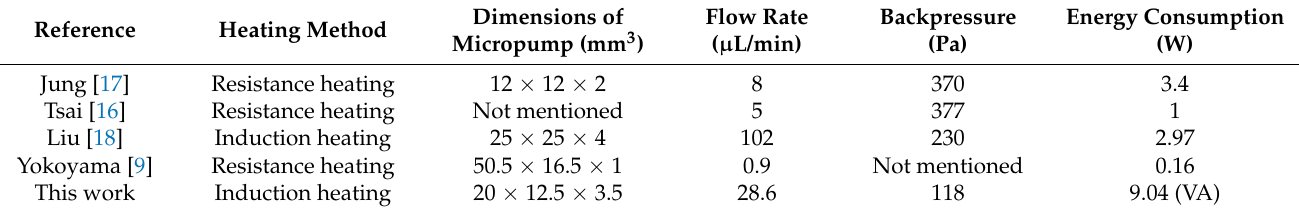
Table 1. Performance comparison between this work and other thermal driven